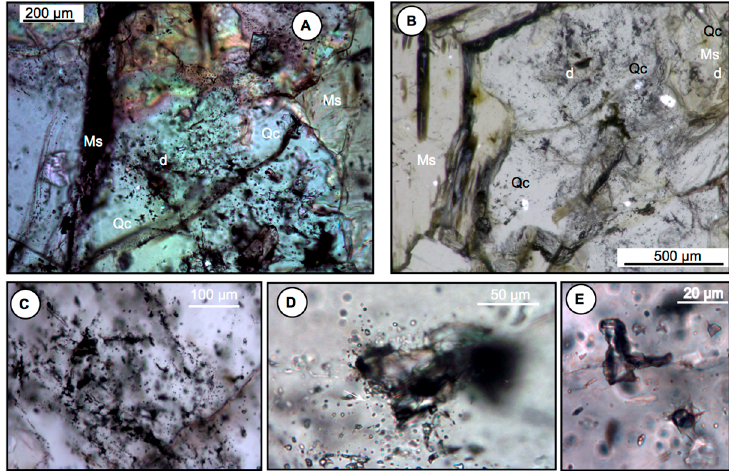
Figure 10. Photomicrographs of fluid inclusion (FI) evidence for an early silicification event in the greisenised G4 granite (level L1, sample PAN-XV-4, plane-polarized light). ( A ) Existence of a halo of clear quartz (Qc) around the package of decrepitated FIs (d). ( B ) Clear quartz halo (Qc) isolates the decrepitated FI packages (d) from the surrounding muscovite (Ms). ( C ) Detail of a set of decrepitated FI. ( D ) A large decrepitated FI with a halo of newly formed satellites (arrow). ( E ) Stretched FIs.